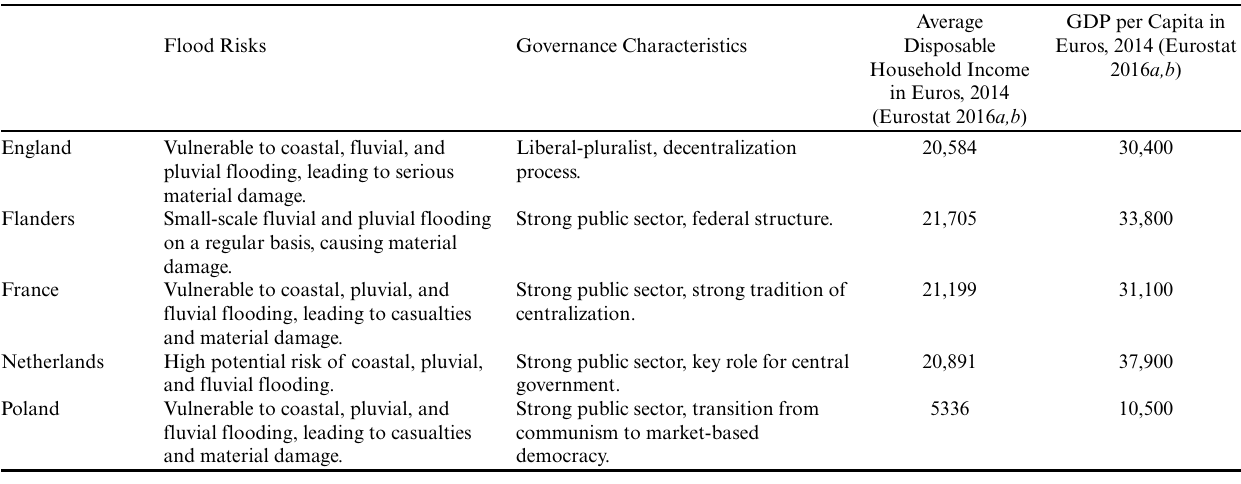
Table 1 . Flood risks, governance, and economic characteristics of the investigated countries. Figures at country level are included for Flanders (Belgium) and England (United Kingdom) to enable the use of data sets with the same